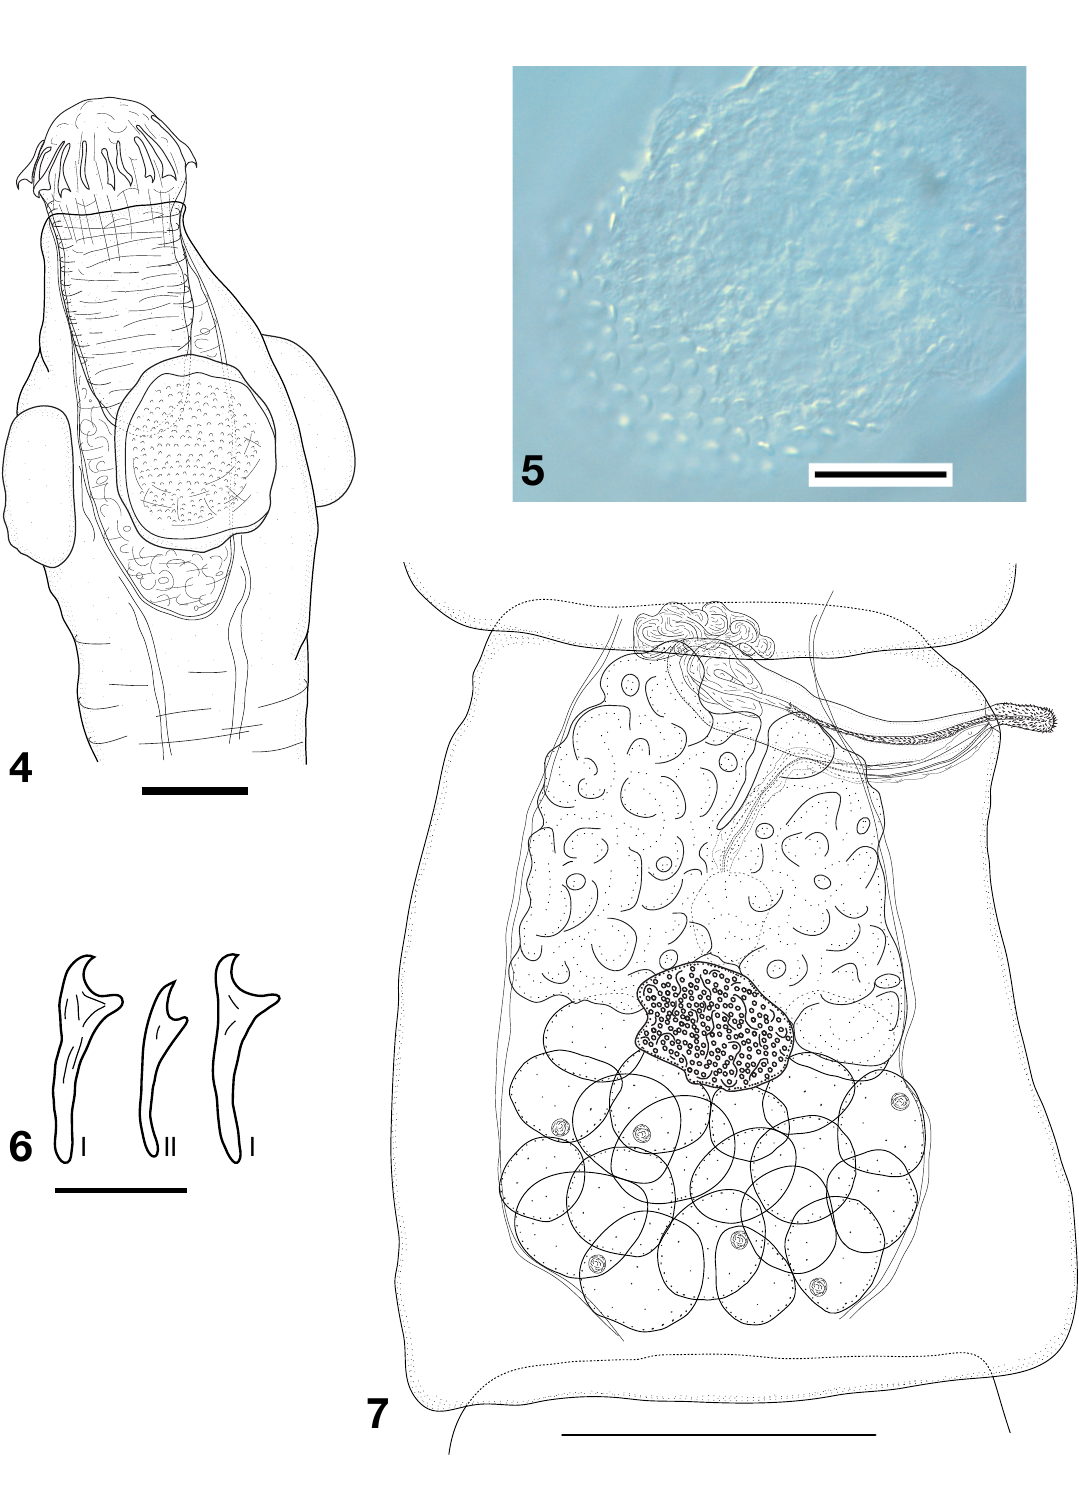
Figs 4–7. Sobolevitaenia anthusi (Spasskaya, 1958). 4 . Scolex. 5 . Sucker spines. 6 . Rostellar hooks Figs 4-7. Sobolevitaenia anthusi . 4 . Scolex; 5 . Suckers spines; 6 . Rostellar hooks (I: anterior, II (I: anterior, II posterior). 7 . Mature proglottis, ventral view. Scale bars: 4 = 50 µm; 5–6 = 20 µm; posterior); 7 . Mature proglottis, ventral view. Scale bars: 4 = 50µm; 5, 6 = 20µm; 7 = 200 µm. 7 = 200